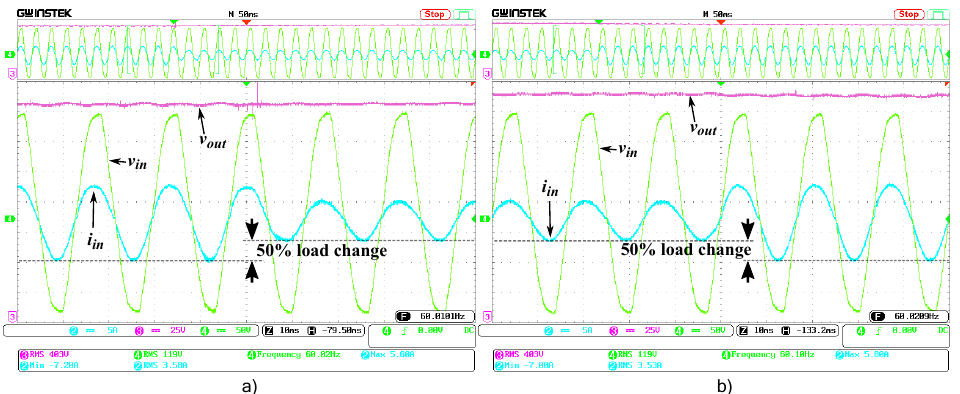
Figure 21. Experimental results with SMC for load changes: ( a ) load increases to 50%; and ( b ) load decreases to 50%.